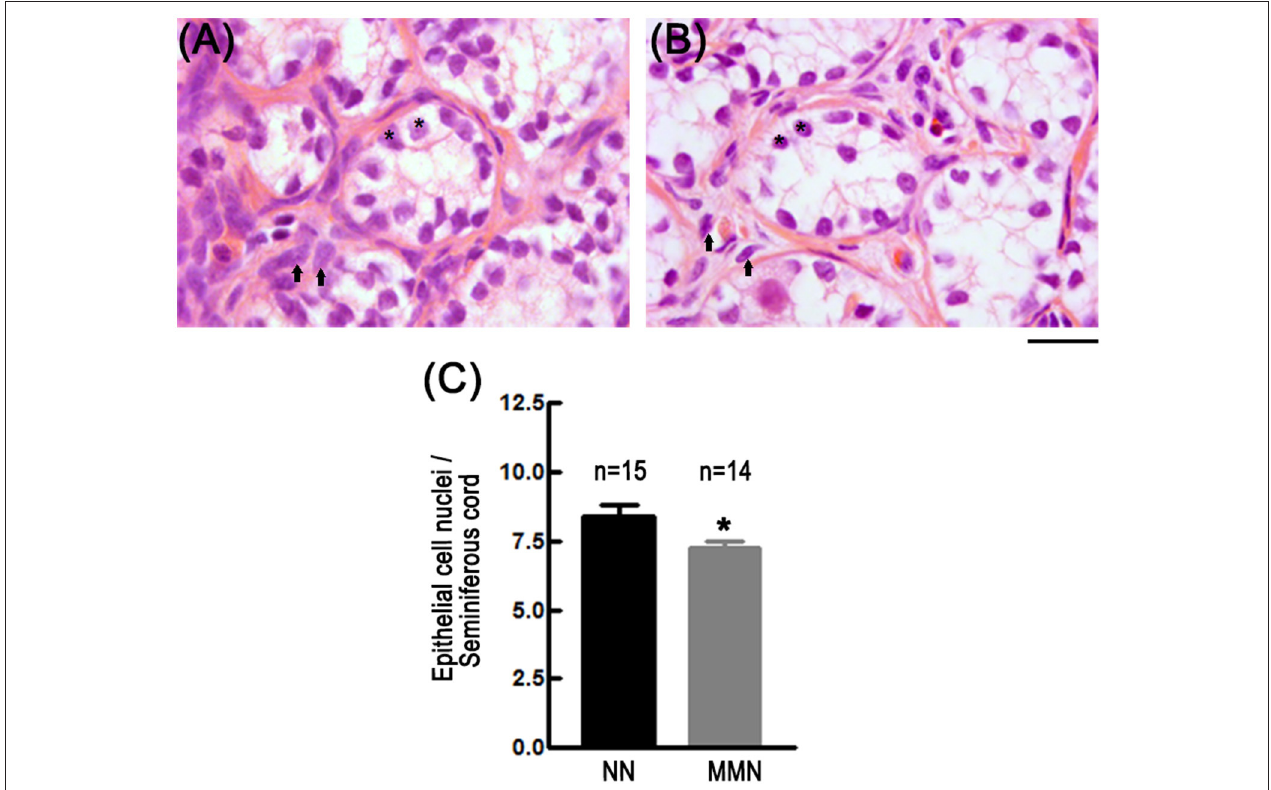
FIGURE 2 | Photomicrographs of histological sections showing epithelial cells of seminiferous cords in NN (A) and MMN (B) hatchlings. Notice that testicles of MMN hatchlings have hypotrophic epithelial (*) and interstitial cells (arrows). The connective tissue surrounding seminiferous tubules is more compact in NN than in MMN hatchlings. Hematoxylin-Eosin staining. Scale bar = 20 µ m. (C) Bar graph that depicts epithelial cell number per seminiferous cord in NN and MMN hatchlings [Nested ANOVA F (1, 23) = 4.84, * p =